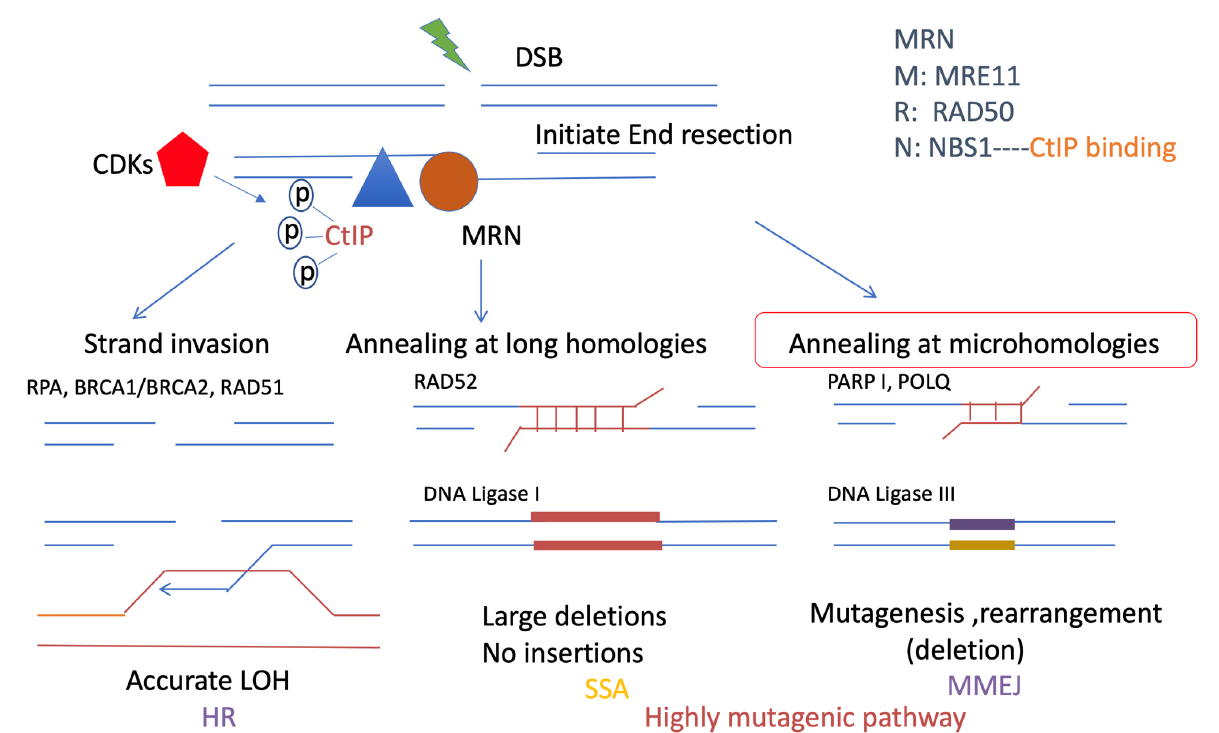
Figure 3. Resection-mediated DSB repair pathways. Resection is important for promoting DSB re-